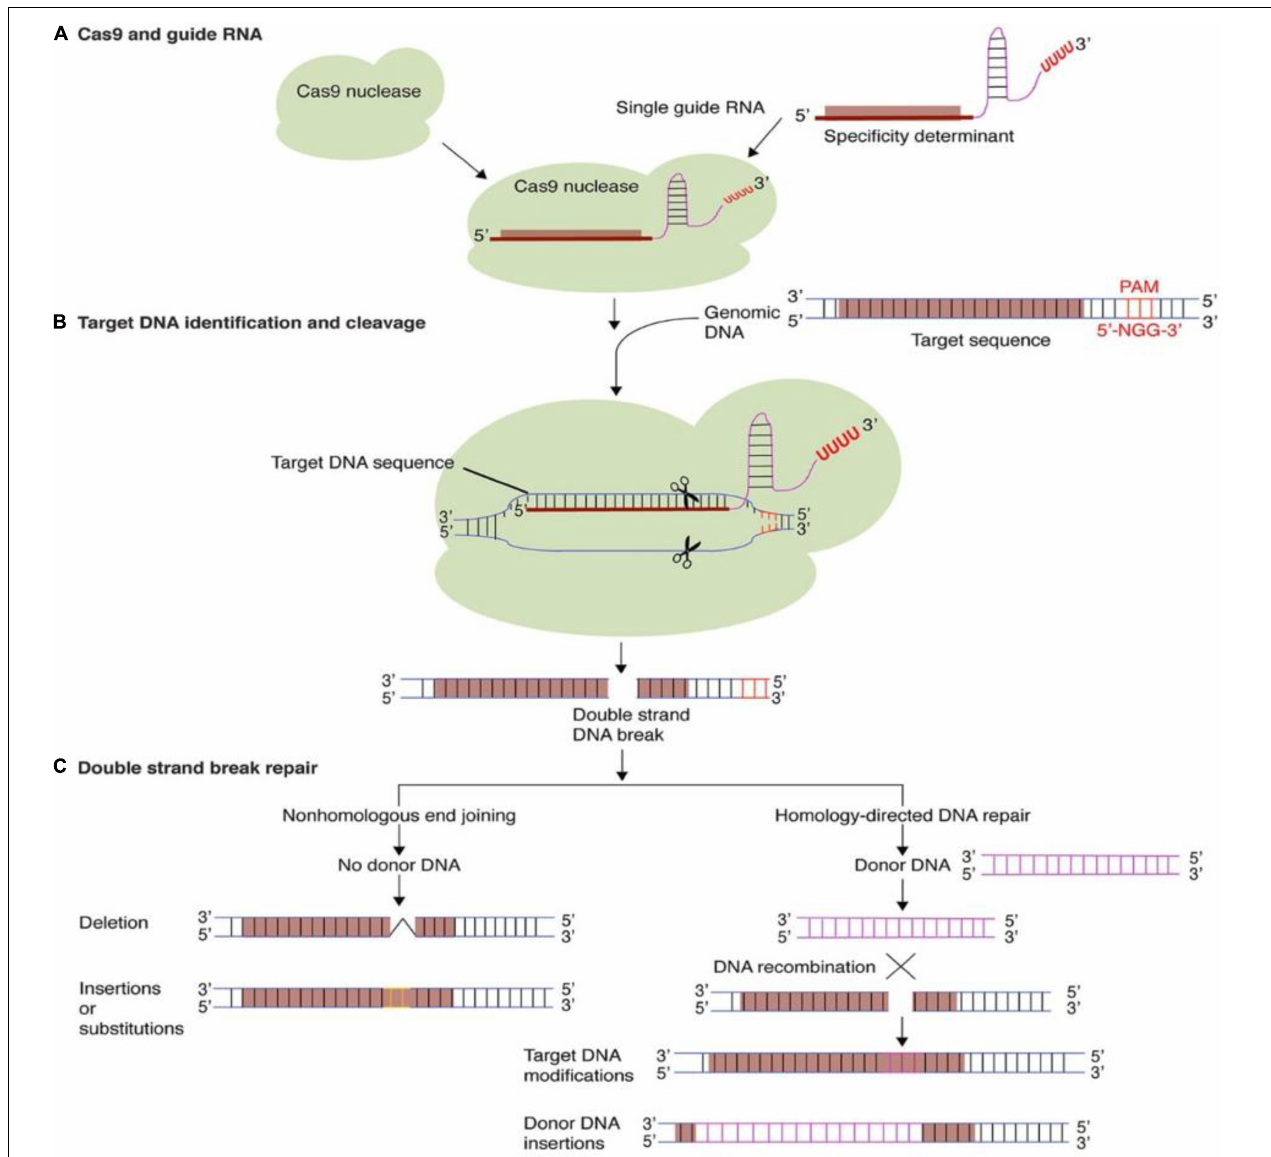
FIGURE 1 | Targeted genome editing via CRISPR-Cas9. (A) The CRISPR-Cas9 system comprises of a Cas9 protein and guide RNA. Guide RNAs regulate the target DNA specificity by sequence complementarity. (B) gRNA and Cas9 protein form a binary complex that specifically cleaves target DNA creating a double-strand DNA break. (C) Cellular DNA repair mechanisms: non-homologous end joining (NHEJ) and homology-directed repair (HDR), repairs the double strand DNA break. In the process, short insertions, deletions, nucleotide substitutions, or gene insertion may occur. Reproduced with permission from El-Mounadi et al. (2020)